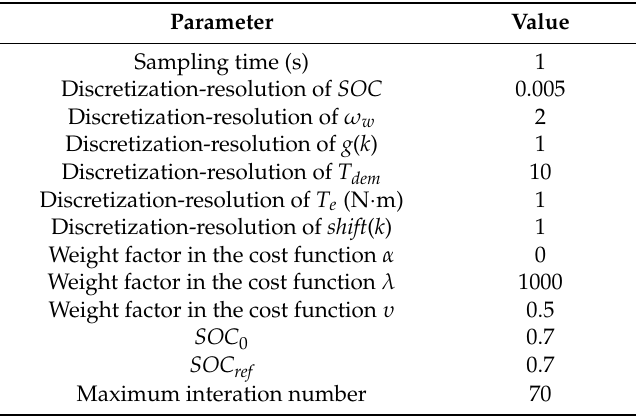
Table 2. Summary of the modeling parameters for parallel